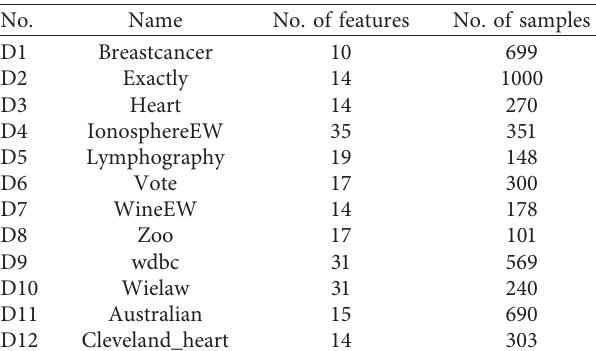
Figure 3: Convergence trends of the GCLPSO and other methods. Table 6: Description of 12